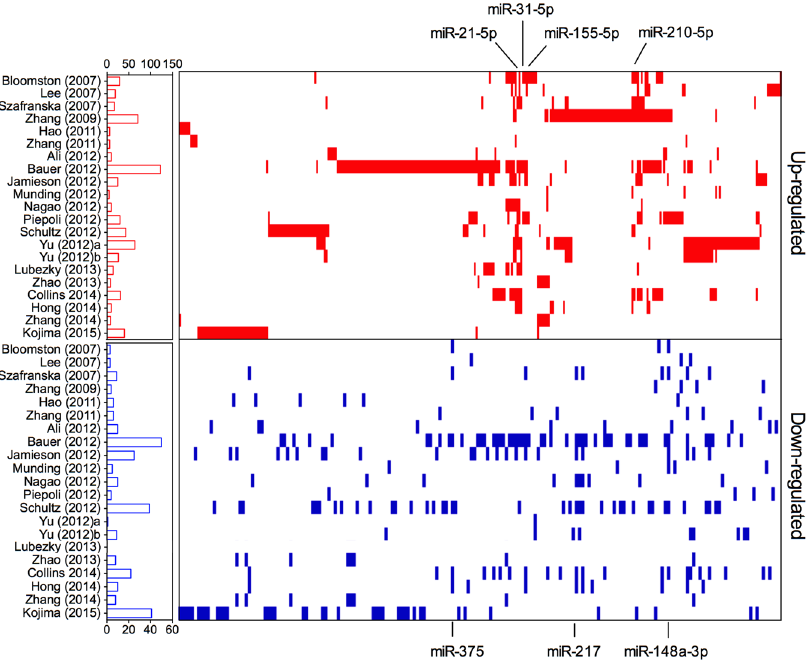
Figure 1. Distribution of miRNA alterations in PC as reported in 21 miRome profiling studies. Short red indicated up-regulated miRNAs and blue vertical bars indicated down-regulated miRNAs. The number of miRNAs in each study is graphically depicted on the left. The positions of meta-signature miRNAs have been marked.